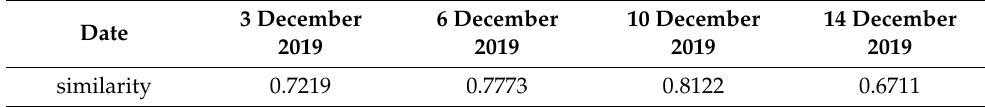
Table 5. Selection results of similar